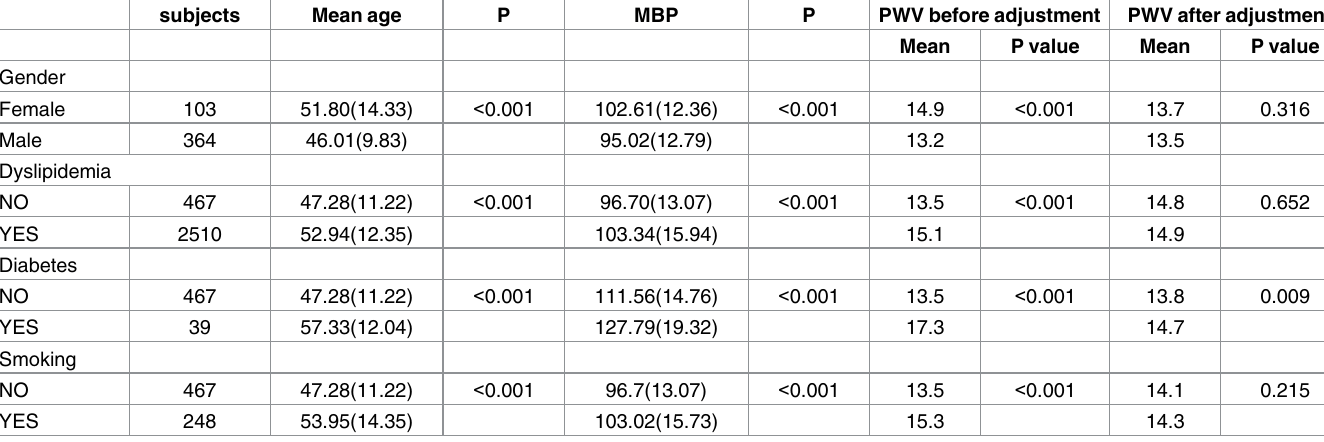
Table 4. Inflence of gender, dyslipidemia, Diabetes and smoking on baPWV(m/s) before and after adjustment for age and mean blood pressure